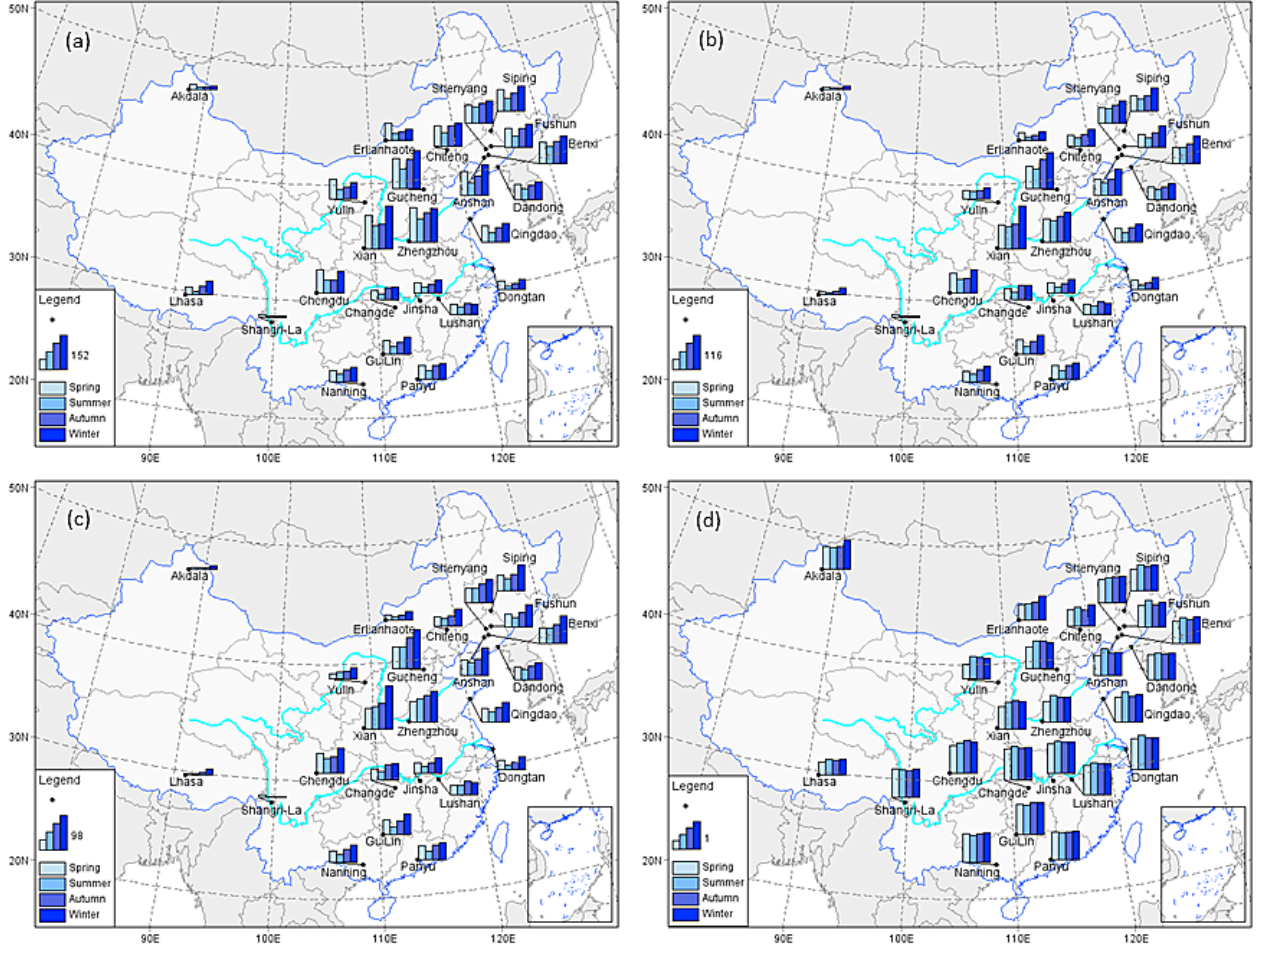
Figure 4. Spatial distribution of the seasonal average concentrations (µgm − 3 ) of (a) PM 10 , (b) PM 2 . 5 , (c) PM 1 and (d) ratios of PM 2 . 5 / PM 10